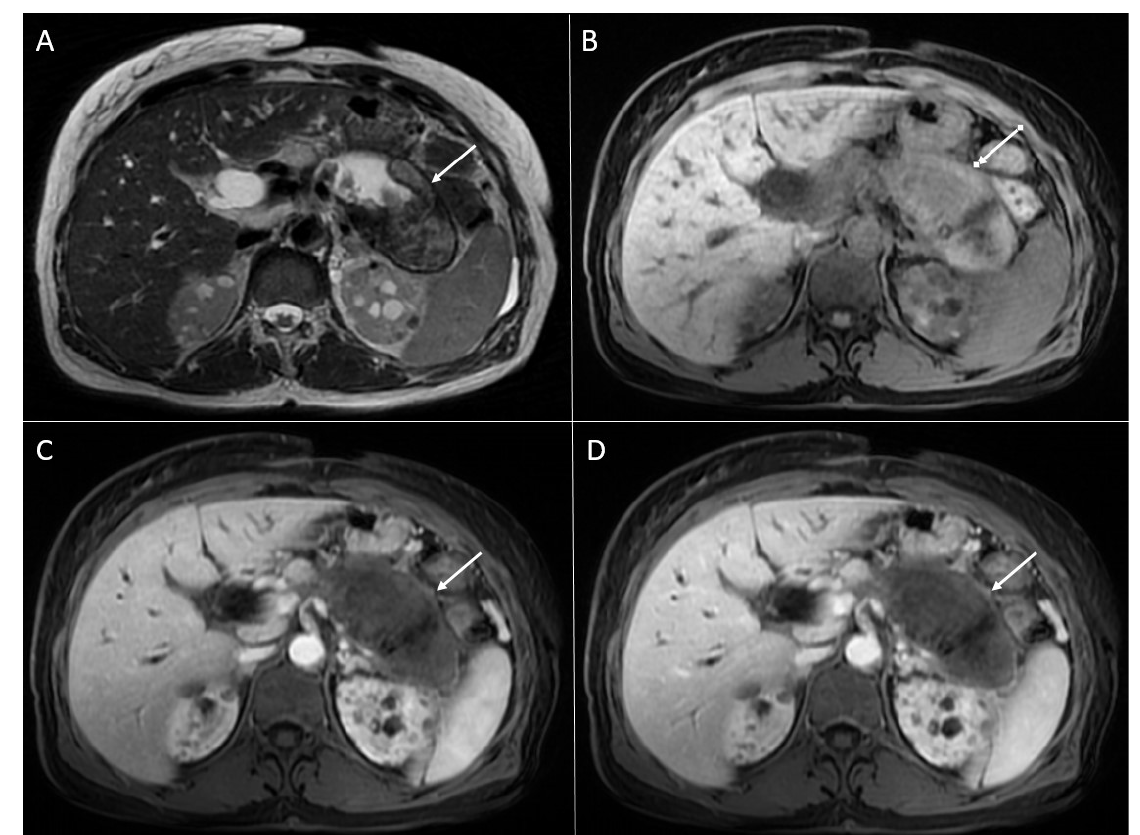
Figure 13. Walled-of necrosis in 54-year-old woman. On T2-weighted image ( A ), large heterogeneous partly cystic lesion ( arrow ) is seen in the pancreatic body and the tail. The lesion ( arrow ) is predominantly hyperintense on T1-weighted FS image ( B ) without opacification in late arterial phase ( C ) and portal-venous phase ( D ).